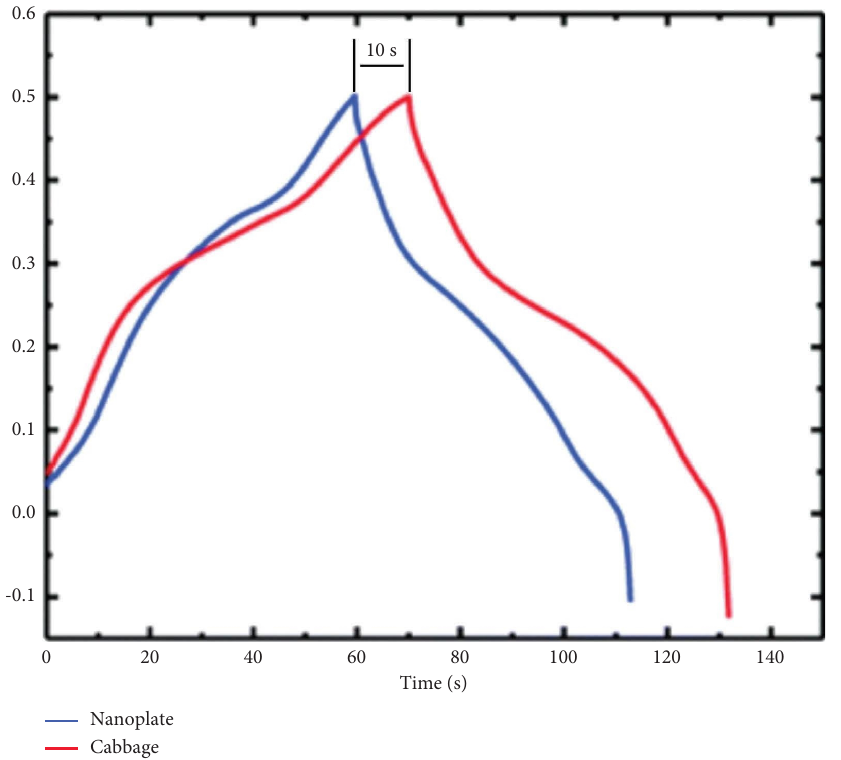
Figure 9: Charging and discharging graph of the cobalt hydroxide sample